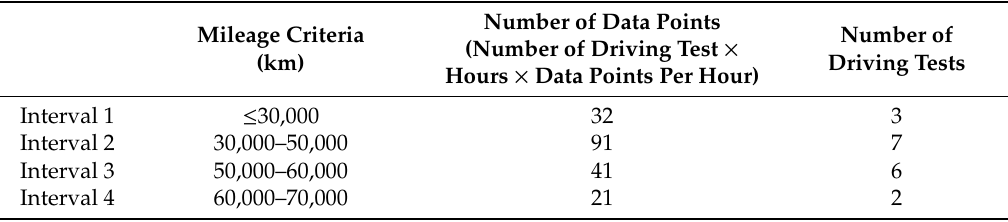
Table 3. Specifications of data collected by mileage intervals.